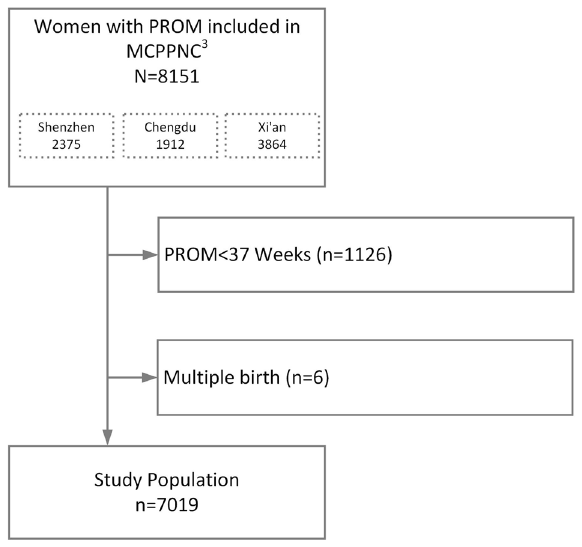
Figure 1. The flow chart summarizes how the sample size of the analysis was